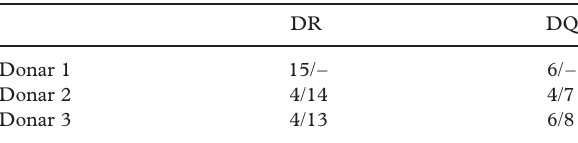
Table I. HLA class II